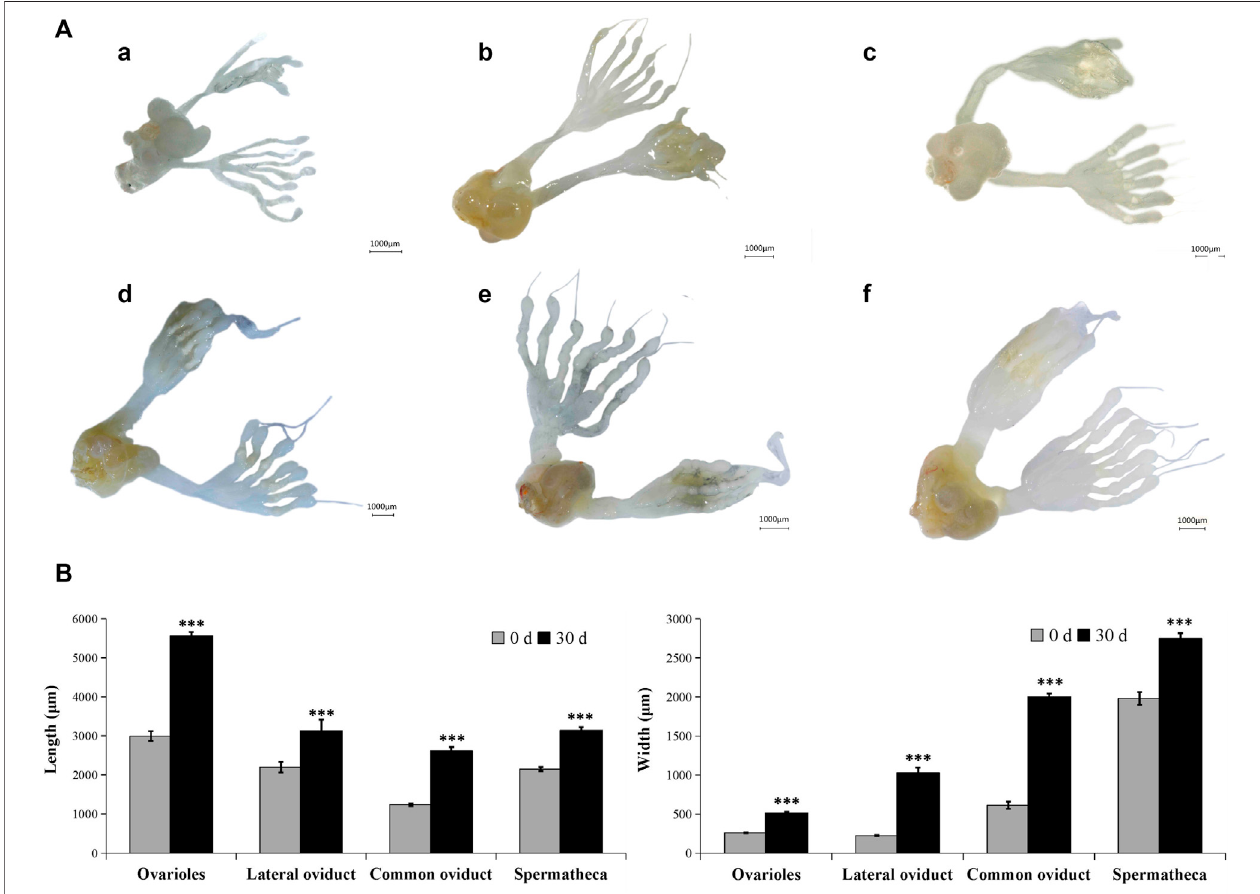
FIGURE 3 | Development pattern of female reproductive system after JHIII injection. (A) Photograph of female reproductive system at different day after JHIII injection. a, 0th day; b, 7th day; c, 14th day; d, 21st day; e, 28th day; f, 30th day. (B) Length and width of female reproductive structures (ovarioles, lateral oviducts, common oviduct, spermatheca). ***, p < 0.001 (independent t